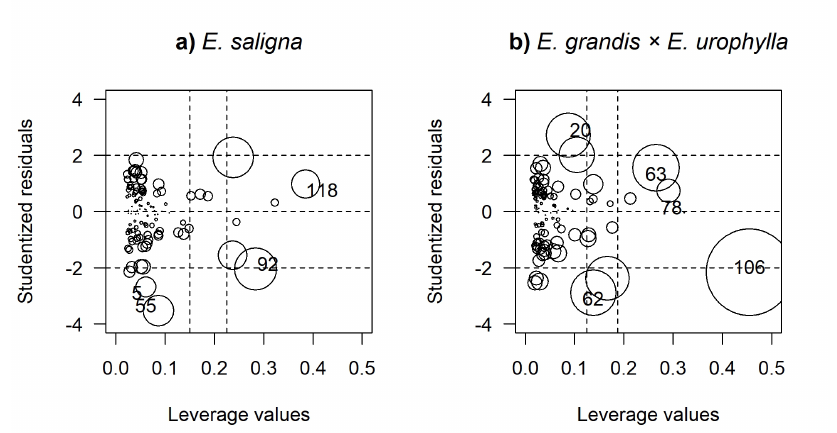
Figure 2 - Studentized residuals by leverage values in the residual biomass estimation of wood harvesting in E. saligna ( a ) and E. grandis × E. urophylla ( b )